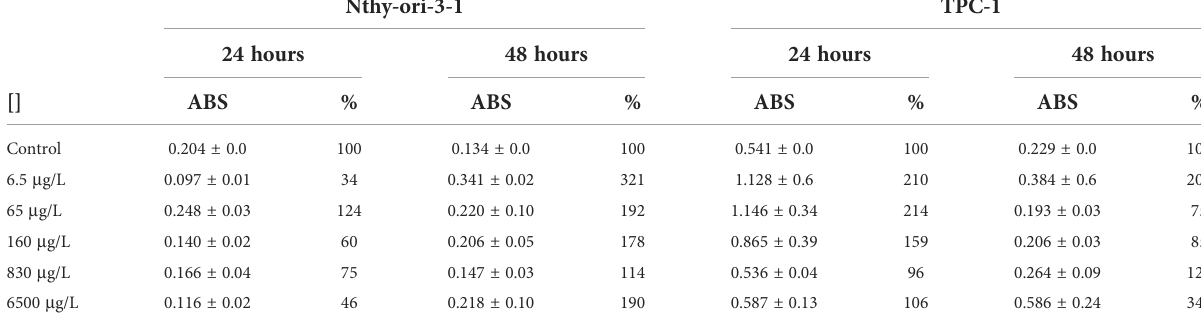
TABLE 3 Absorbance of BrdU and percentage of Nthy-ori 3-1 and TPC-1 cells after exposure to Roundup ® Original DI for 24 h and 48 h at different